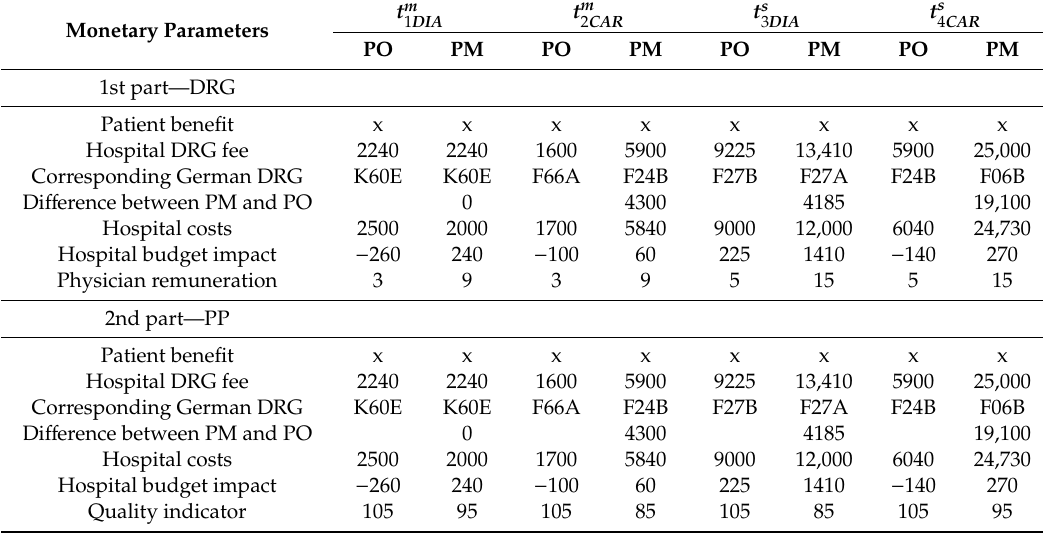
Table A1. Monetary Parameters for Hospital Physicians—Treatment Cases